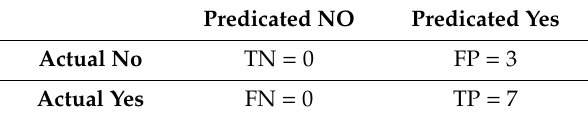
Table 9. Confusion matrix of snow class.